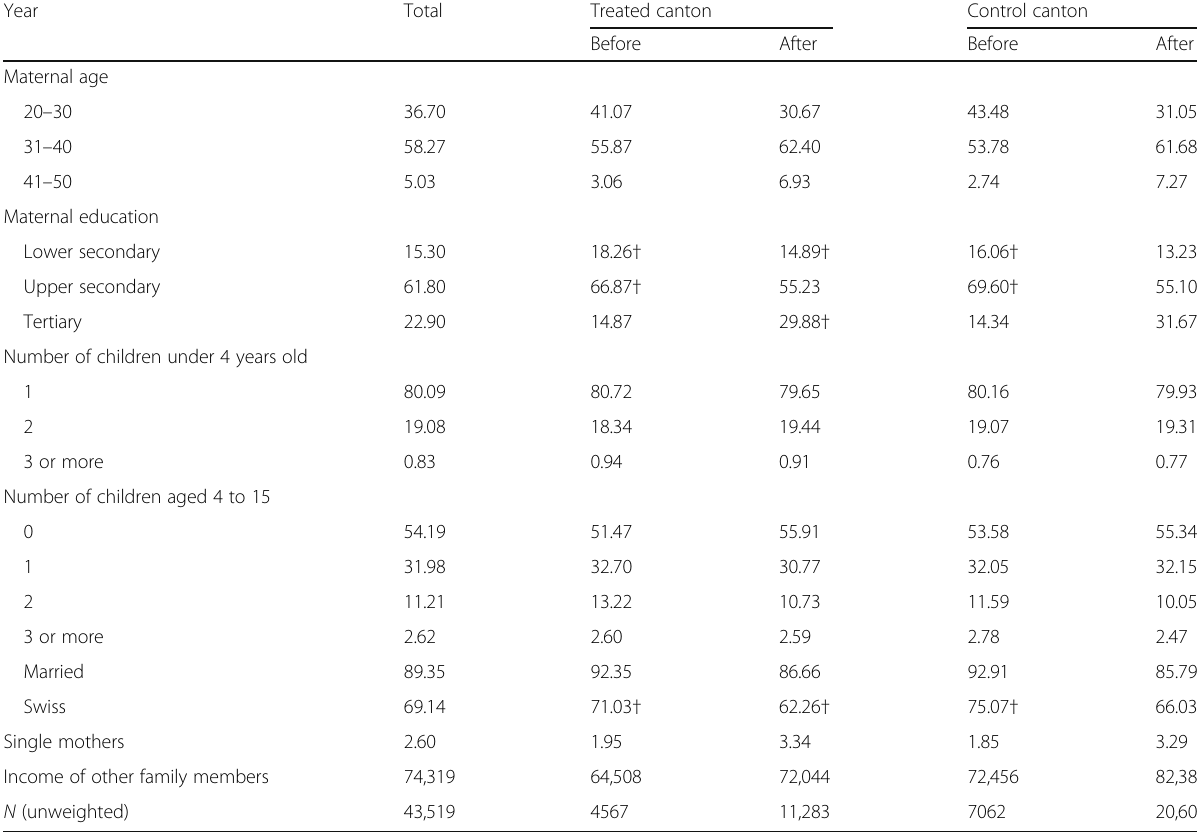
Table 2 Sample description of mothers with children between 0 and 3 years of age before and after the reform Year Total Treated canton Control canton Before